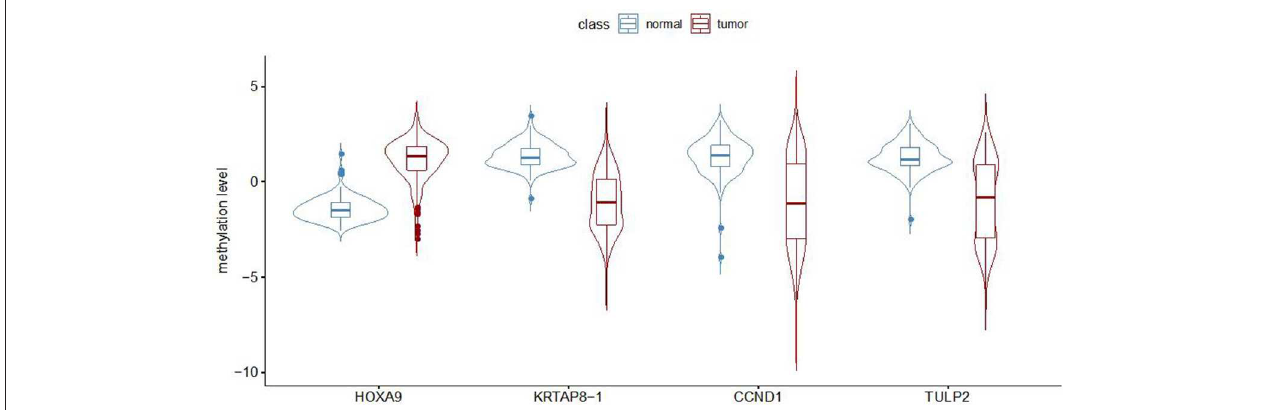
FIGURE 3 | Analysis of the methylation level of the four selected probes. (A) The beta value for the four selected probes was calculated from the TCGA dataset representing lung adenocarcinomas and non-malignant samples, with the measurements being done on the Illumina Infinium HumanMethylation27 BeadChip platform. (B) Analysis of the TCGA data generated on the Illumina Infinium HumanMethylation450 BeadChip platform.